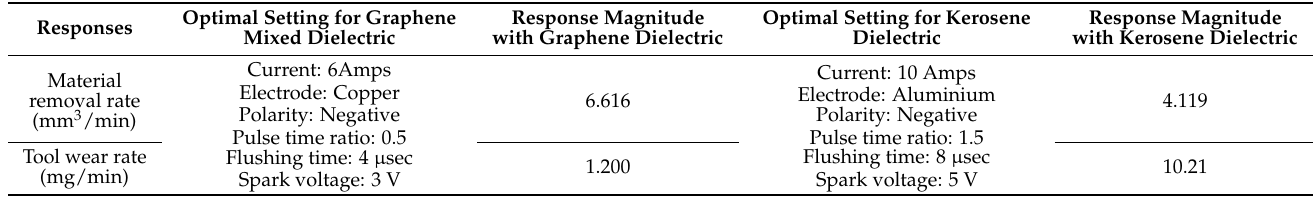
Table 7. Multi-object optimization of optimal